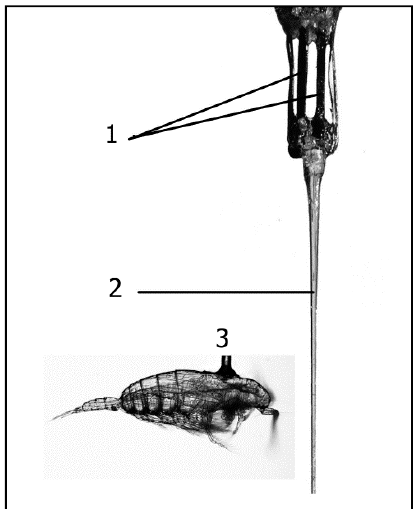
Figure 10. Force sensor ( 1 and 2 : frontal view) and Calanus helgolandicus ( euxinus ) female ( 3 : lateral view) attached to the end of the glass rod. 1 ― four semiconductor tensoresistors of 2 × 0.2 × 0.05 mm, pairwise connected in one plane according to the scheme of the Wheatstone bridge; 2 ― glass rod of 4 mm length in the case of measuring the force production of copepods during the escape reaction and 8–10 mm in the case of routine locomotion.